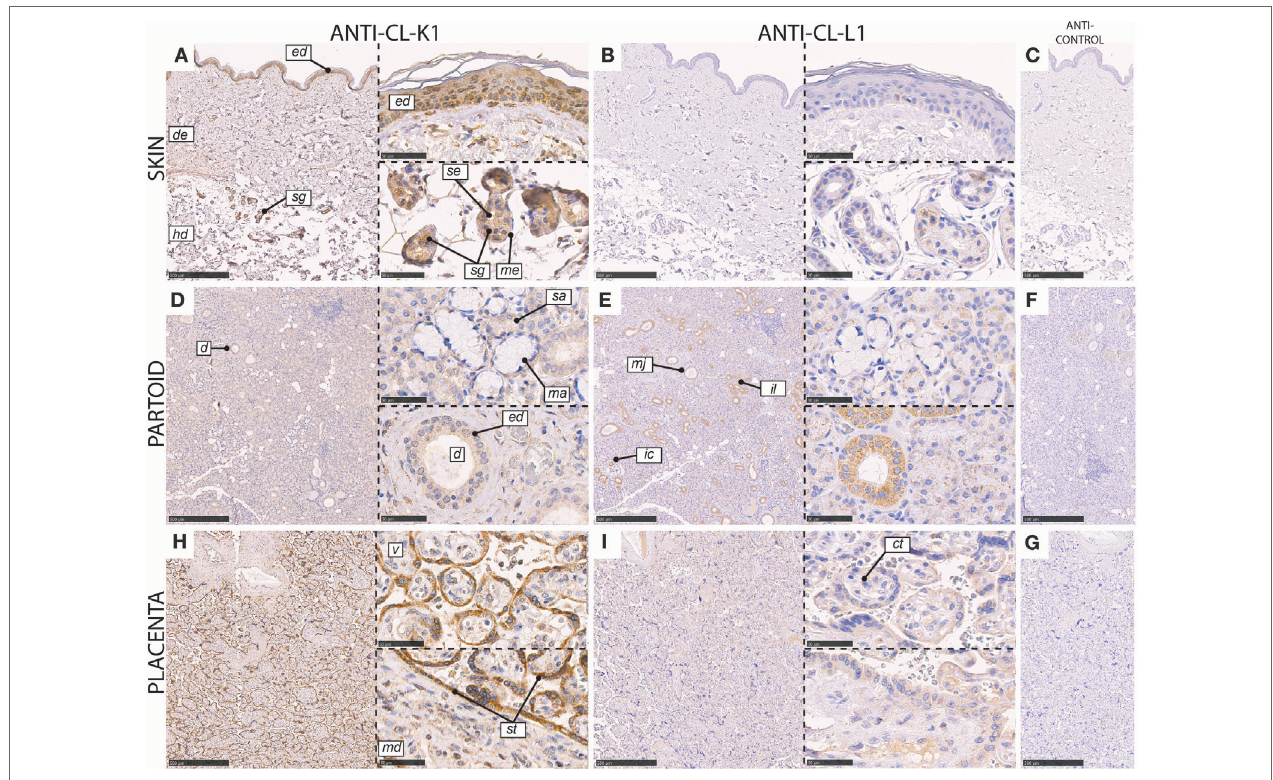
FigUre 7 | Immunohistochemical localization of CL-K1 and CL-L1 in formalin fixed and paraffin embedded sections of the skin (a,B) , parotid gland (D,e) , and placenta (h,i) . Italic letters within images refers to: for the skin ed : epidermis, de : dermis, hd : hypodermis, sg : sweat glands, me : myoepithelial cells, and se : stratified cuboidal epithelia cells; partoid salivary gland d : duct, ed : epithelial ductal cells, sa : serous acini, ma : mucous acini, mj : major duct, il : intralobulated duct, and ic : intercalated duct; placenta v : villus, st: syncytiotrophoblast, ct : cytotrophoblast, and md : mesoderm. Scale bars in large sections and in isotype control sections (c,F,g) correspond to 500 µm and in small sections to 50